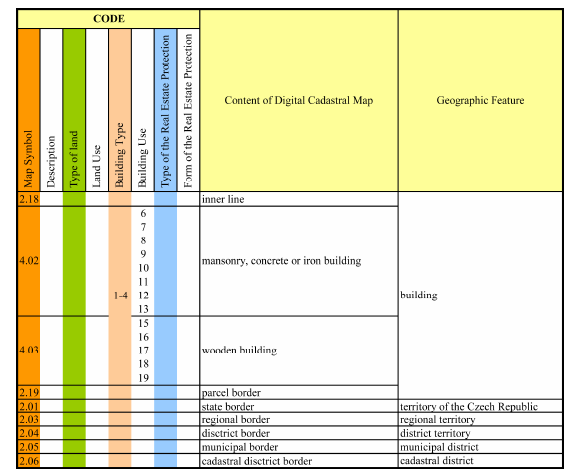
Figure 1. Examples of the content of digital cadastral map in the Czech Republic. Reference data are defined by INSPIRE as series of datasets that everyone involved with geographic information uses to